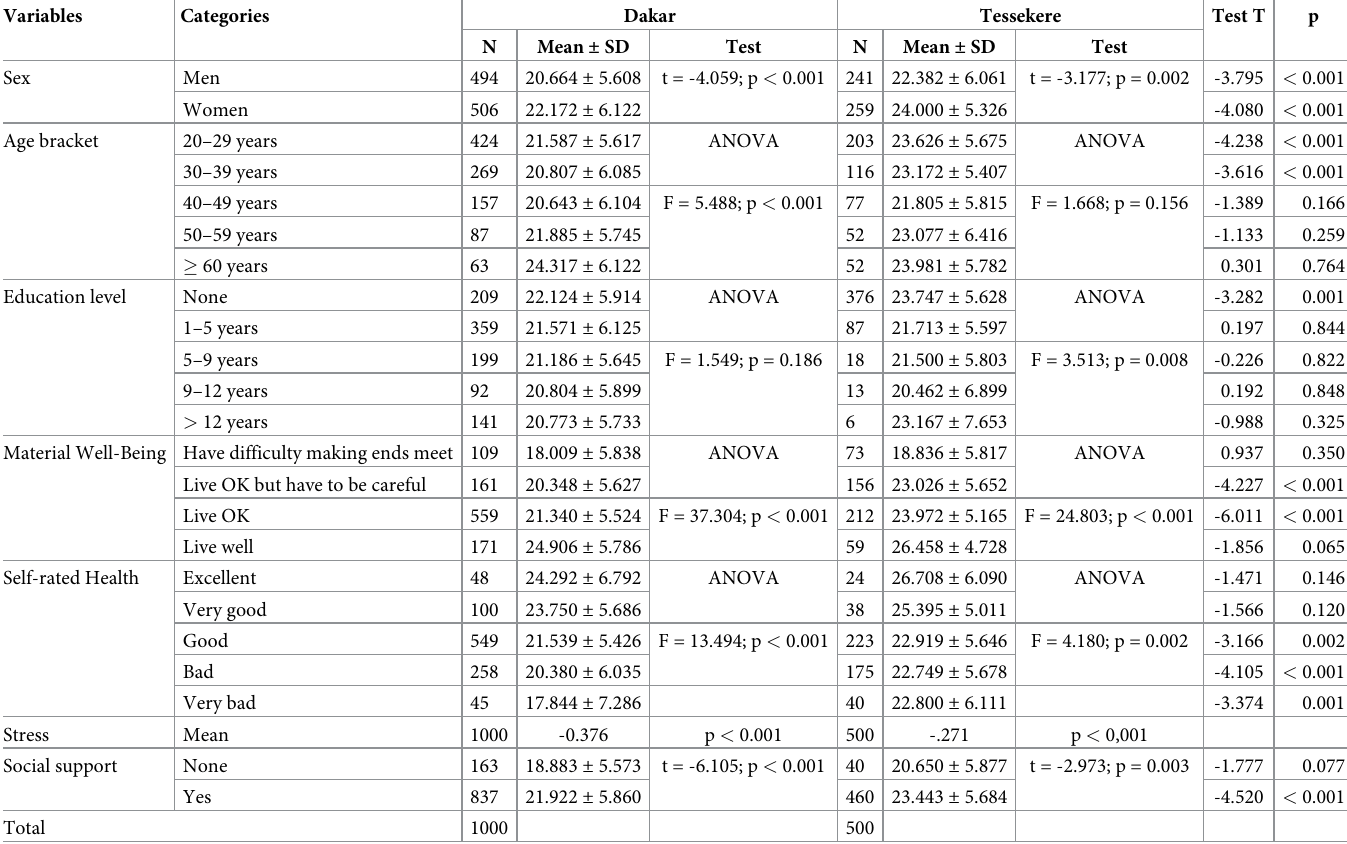
Table 2. Life satisfaction (mean) by demographic, socioeconomic and health related variables (N = 1500). Variables